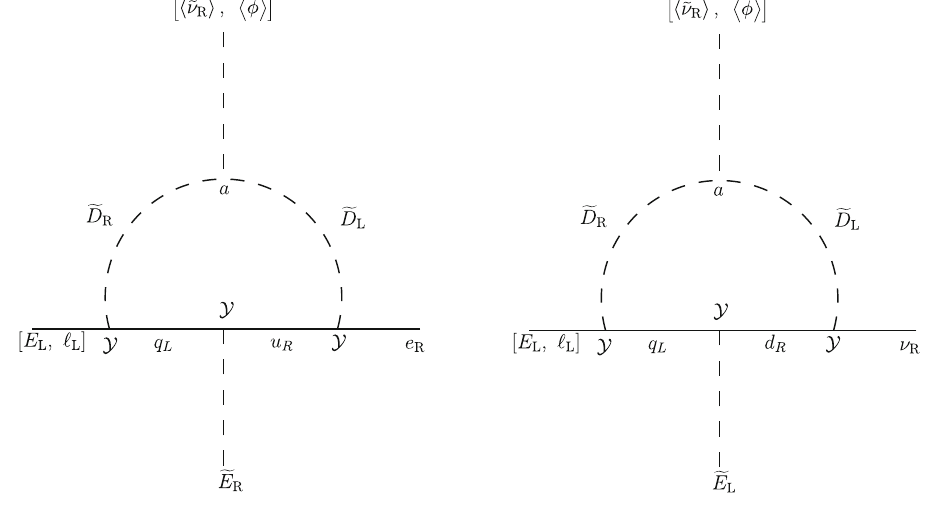
Fig. 5 Examples of one-loop diagrams contributing to the radiatively generated lepton Yukawa couplings, in addition to the topologies in Fig. 4. The indices L , R refer to the original tri-triplets given in Eq. (2.25).